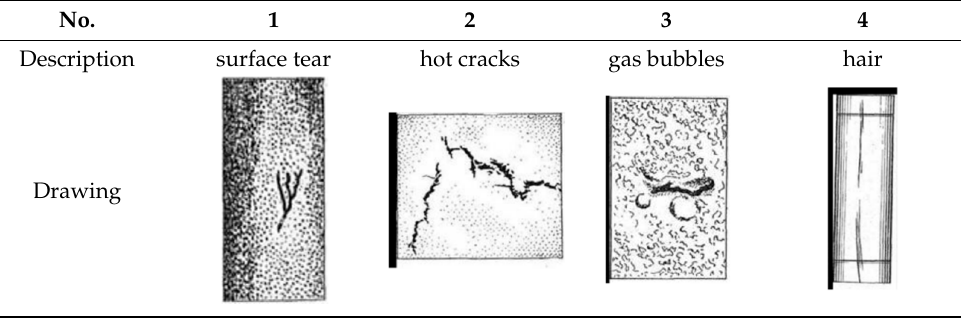
Table 1. Basic types of defects studied in this work.